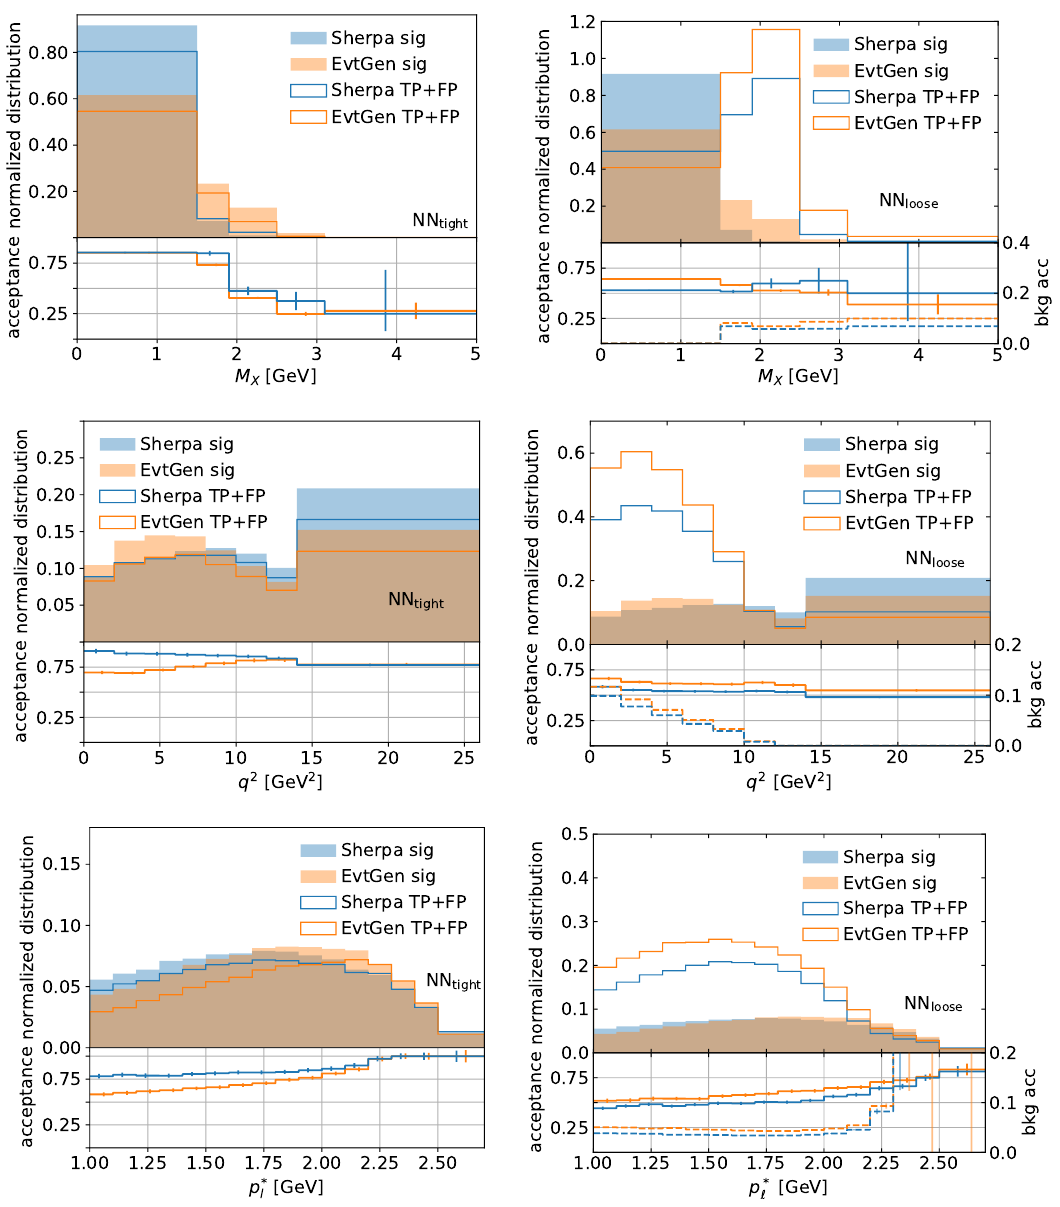
Figure 6 . Distributions and signal acceptance of S HERPA and E VT G EN Monte Carlo data as functions of M , q 2 , and p ∗ for NN (left) and NN (right), trained on E VT G EN data. The X tight loose ‘ distributions in the upper panels of each plot are normalized to the total number of signal events. For NN the dashed lines in the lower panels show the background acceptance, using the scale loose for the y -axis displayed on the right. In the lower panels, error bars highlight the MC uncertainty on the acceptance. The error bars for the background uncertainty, which becomes visible at high p ∗ uses a lighter shade. For bins with very low event numbers, we have used the tabulated uncertainties from ref.